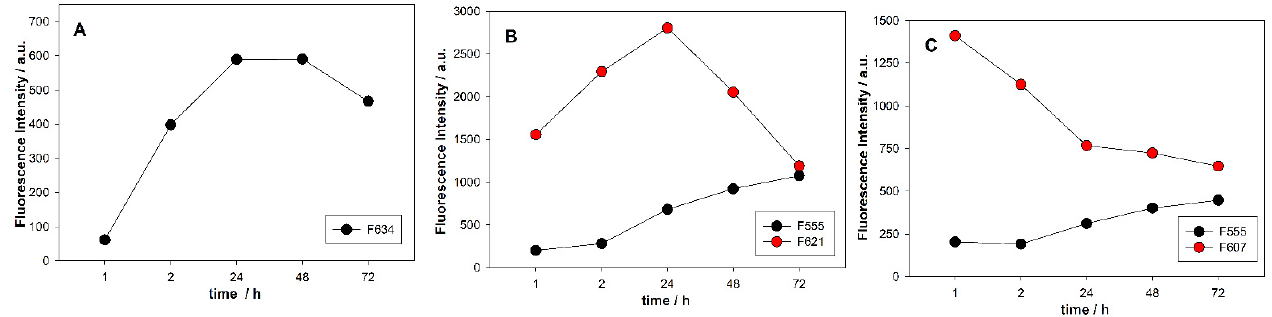
Figure 5. The evaluation emission properties of studied DNA-AgNCs in time: ( A ) C12AgNCs; ( B ) Tel22C12-AgNCs; ( C ) TBAC12-AgNCs. Conditions: 2 μ M probe in 10 mM Tris-acetate (pH = 7.5).